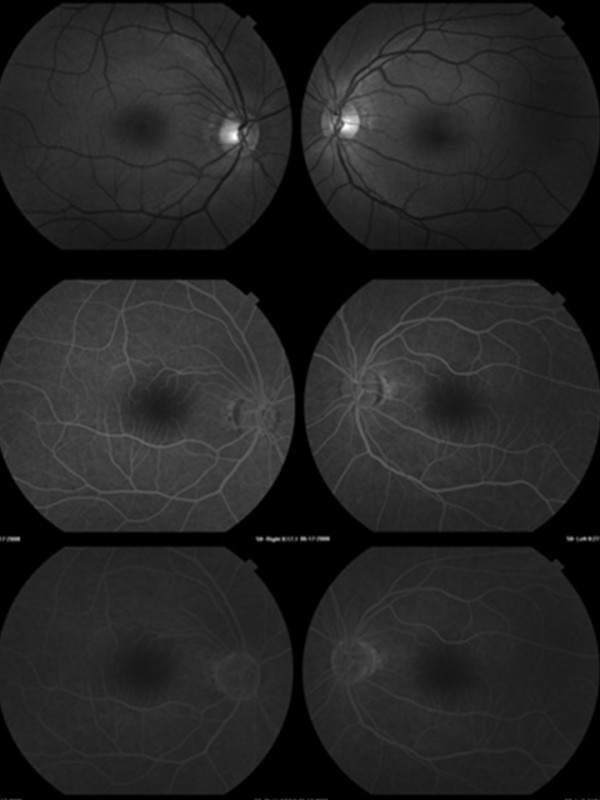
Study of normal angiofluoresceinography.